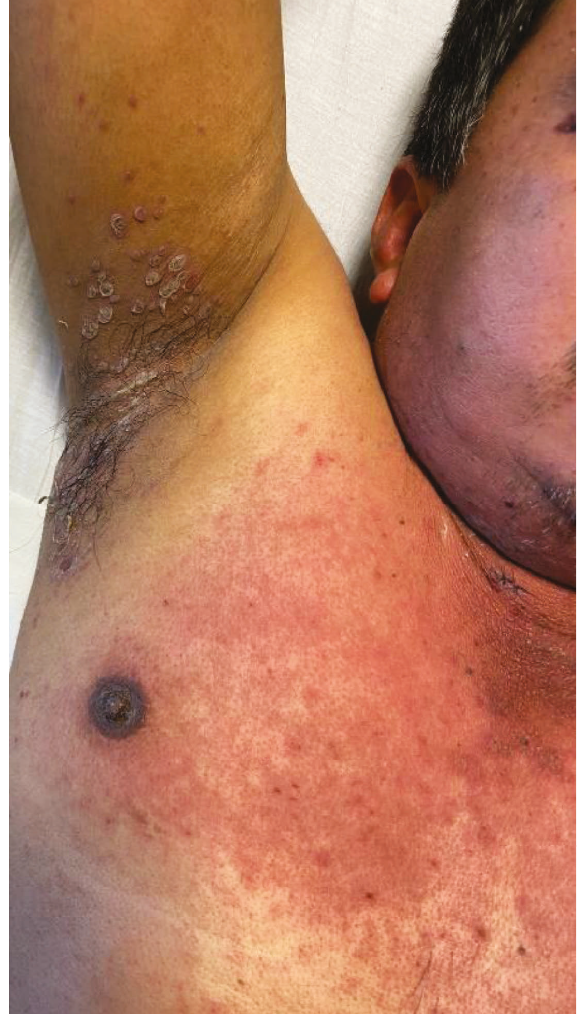
Figure 2: Axillary involvement in the initial